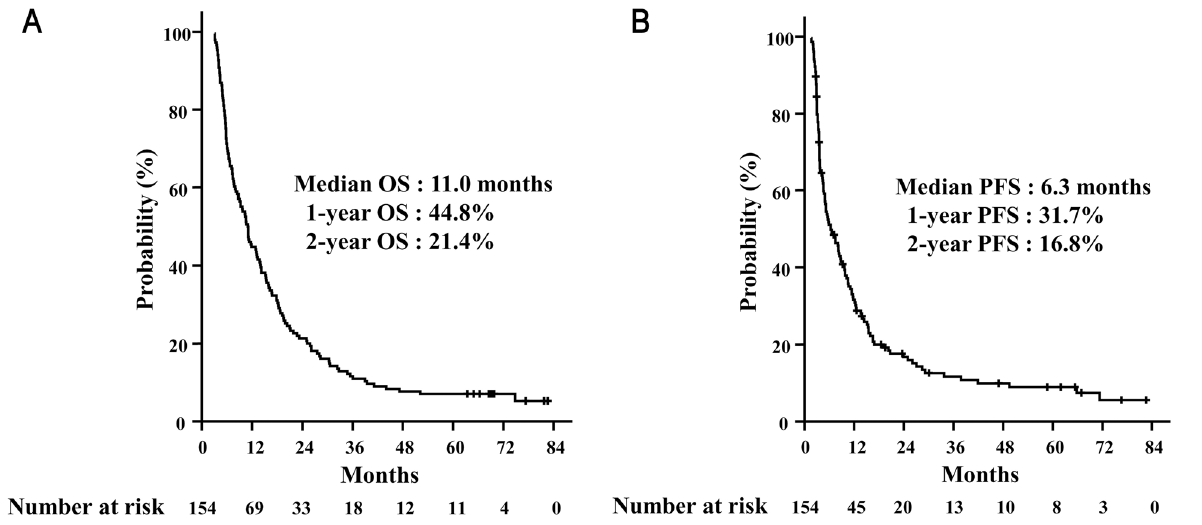
Fig 1. Survival outcomes. Overall survival rates (A) and progression-free survival rates (B) in all patients.